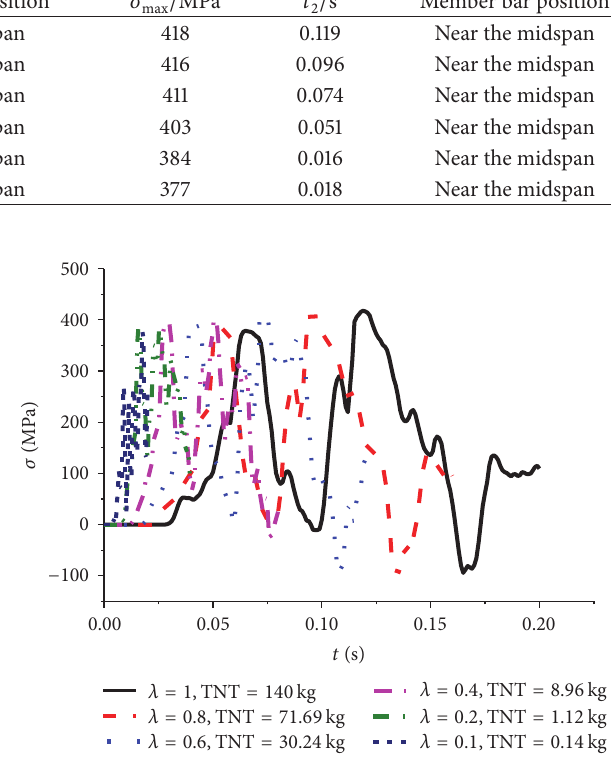
Figure 5: The surface unit peak overpressure values in the reticu- lated shell structure.